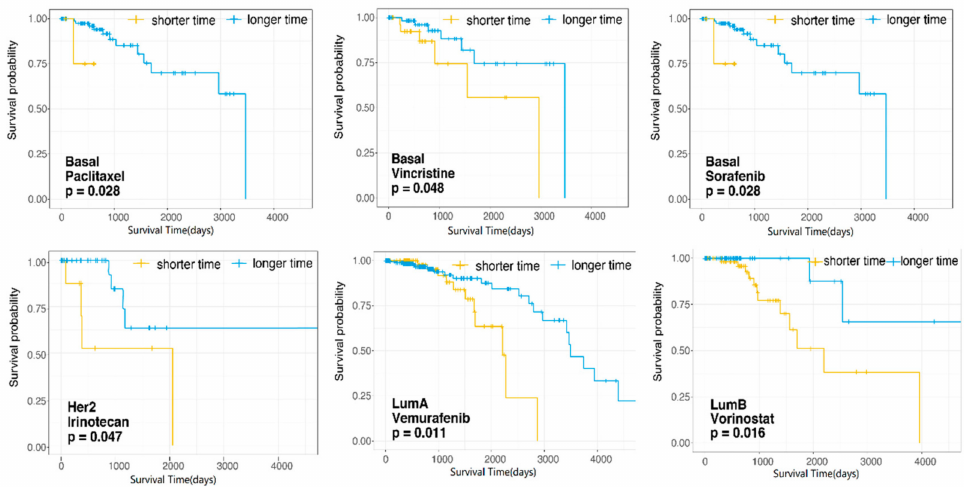
Figure 5. Kaplan-Meier survival curves of patients at shorter survival time group or longer survival time group stratified by drug target signatures of candidate drugs of each breast cancer